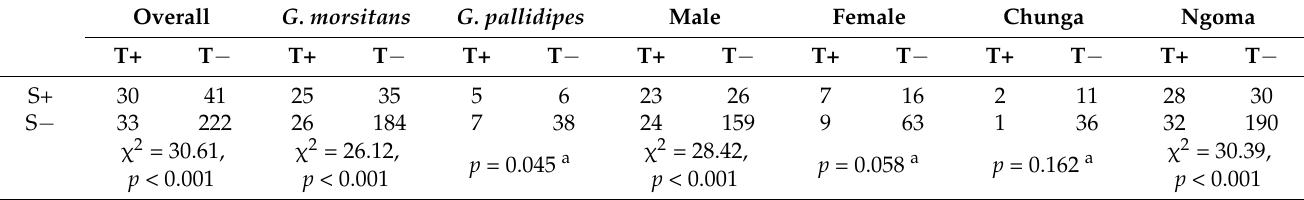
Table 6. Association between S. glossinidius and the presence of trypanosomes.